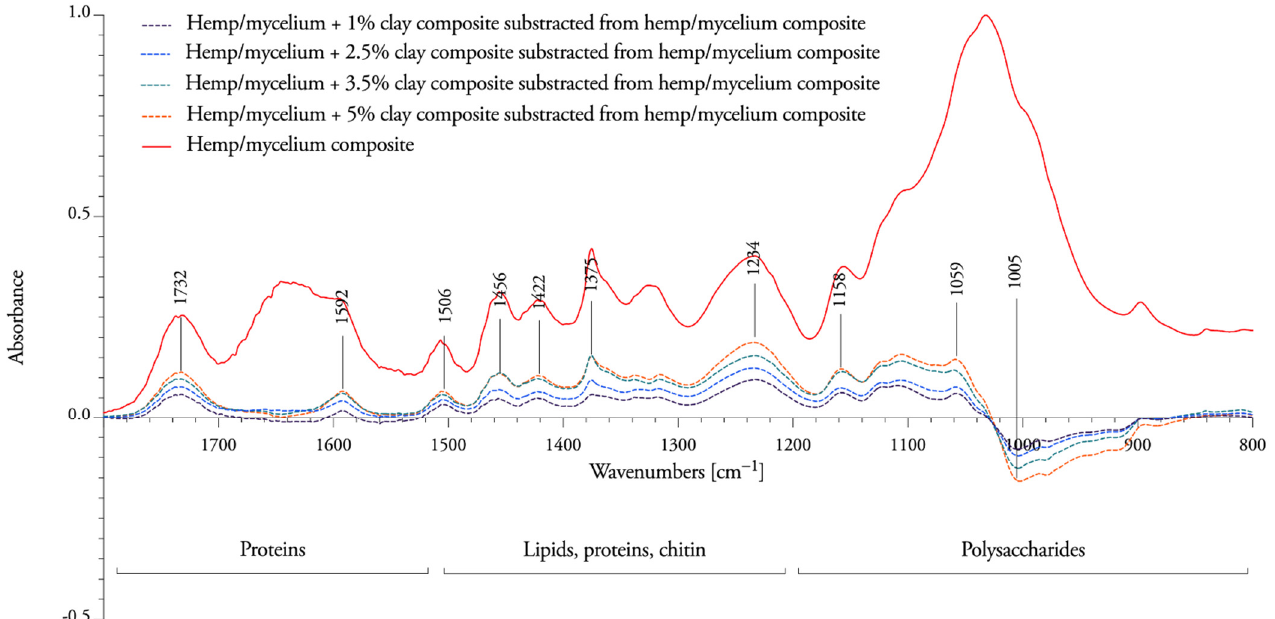
Figure 8. The subtracted peaks of nanoclay–mycelium composite (dotted line) from mycelium composite fibers without clay (solid line) below the baseline show an appearance of new bands due to degradation by the fungi, while the subtracted peaks above the baseline show the decrease of bands. The intensities are around zero when there is no change in the chemical composition of the fibers during the mycelium interaction.